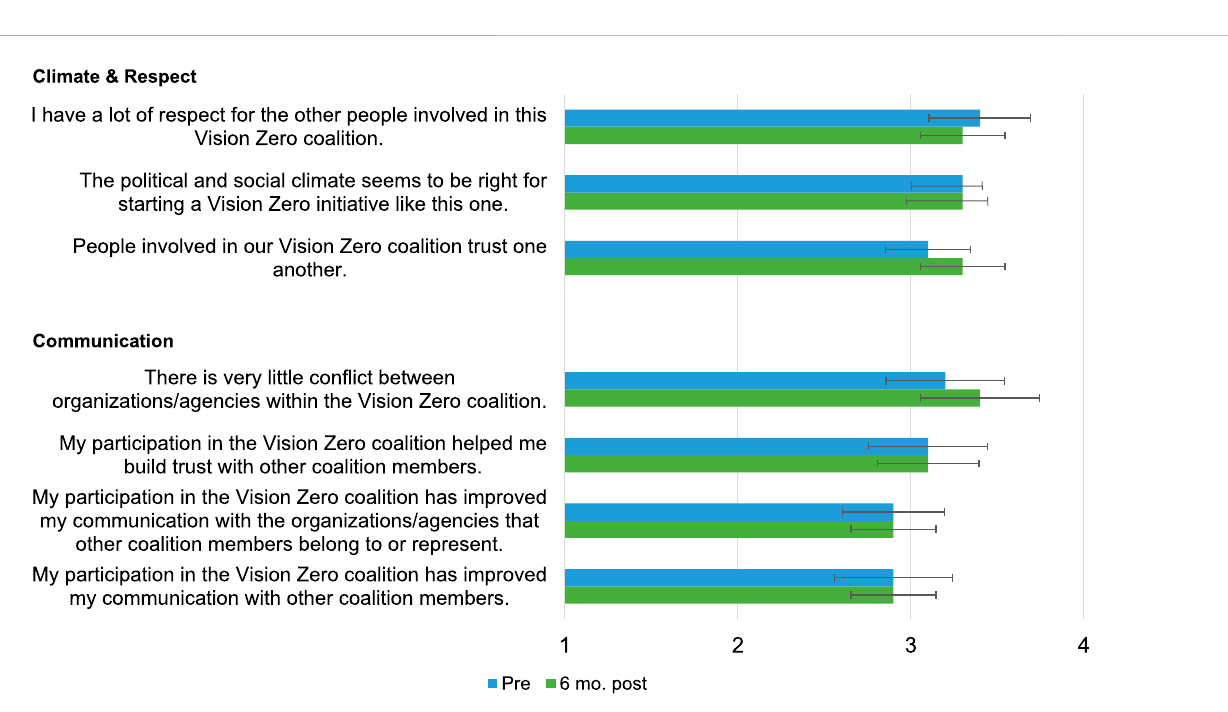
FIGURE 3 Changes* in perceived coalition climate, communication, and respect between Vision Zero Leadership Institute and 6-month post-assessment.